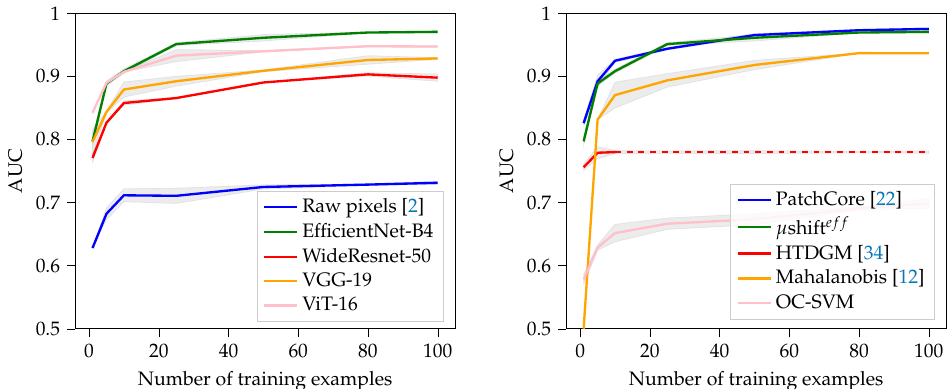
Figure 7. Data efficiency on the MVTec dataset across several analyzed architectures. With more than 10 non-defective training examples, an average AUC above 90% could be achieved using the EfficientNet-B4 or the Vision Transformer Network (ViT) as feature